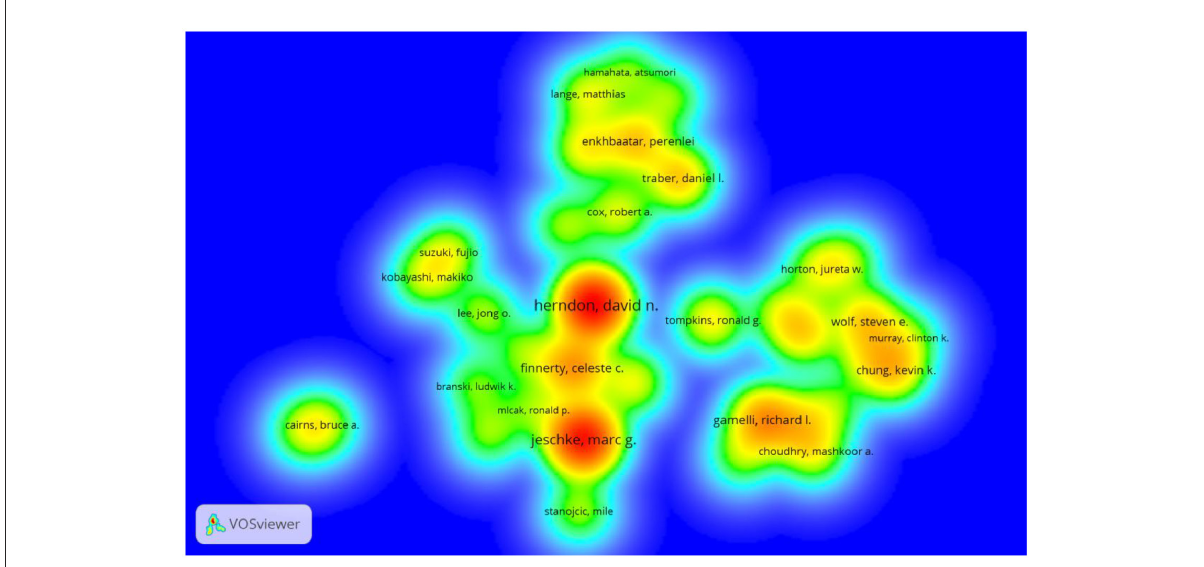
lower frequency of